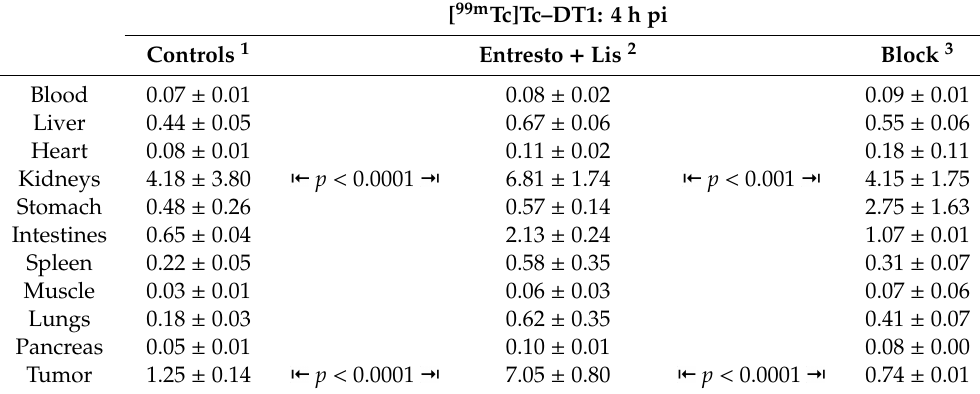
Table 2. Biodistribution data for [ 99m Tc]Tc–DT1, expressed as % IA / g mean ± SD in AsPC-1 xenograft-bearing SCID mice at 4 h pi, without or after treatment with Entresto + Lis. [ 99m Tc]Tc–DT1: 4 h pi Entresto + Lis